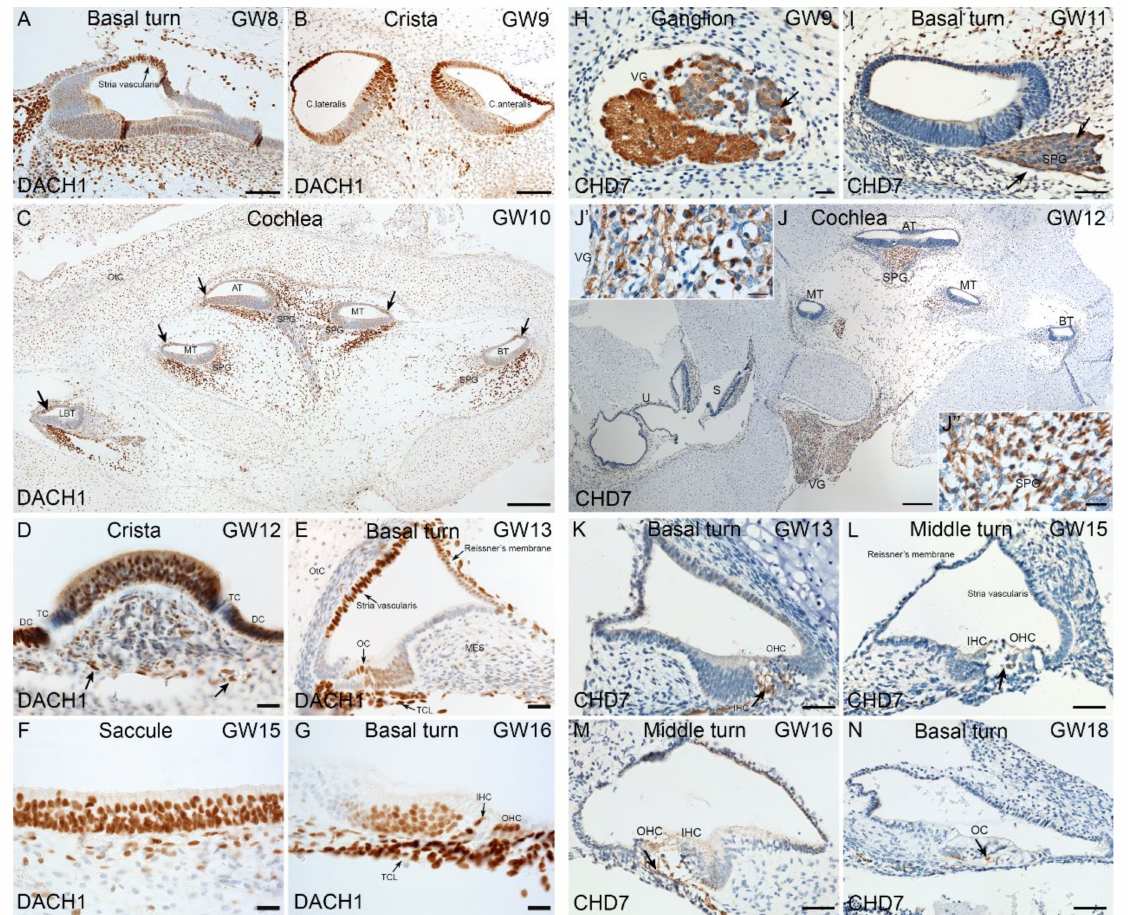
Figure 9. Immunostaining for DACH1 and CHD7 in human inner ear fetal tissue. ( A ) Basal turn of cochlea at GW8. Nuclei of future marginal cells (arrow) in stria vascularis are immuno+ for DACH1. Additionally, mesenchyme cells show strong nuclear staining. ( B ) Cristae ampullaris at GW9. The HCs of lateral and antral crista exhibit strong immunoreactivity in sensory epithelium. Single layered cuboidal epithelial cells of membranous labyrinth are immuno+. Few immuno+ cells observed in the mesenchyme as well. ( C ) Mid-modiolar plane of cochlea at GW10. Strong immunostaining present in mesenchyme underlying sensory epithelium. Few cells of spiral ganglion exhibit immunoreactivity for DACH1. Future stria vascularis (arrows) is immuno+ for this marker. ( D ) Crista ampullaris at GW12. Immunoreaction is present in vestibular HCs and supporting cells. Non-myelinating Schwann cells (arrow) underlying sensory epithelium appear immuno+. Transitional cells (TC) are devoid of immunoreactivity. The dark cells (DC) appear immuno+. ( E ) Cochlear basal turn at GW13. Stria vascularis and Reissner’s membrane immuno+. In organ of Corti (OC), HCs and supporting cells are immuno+. Cells beneath the basilar membrane forming the future tympanic cover layer (TCL) cells are immuno+. ( F ) Sensory epithelia of saccule at GW15. The HCs and supporting cells show a strong immunoreactivity for DACH1. ( G ) Cochlea basal turn at GW16. Outer (OHC), inner hair cells (IHC) and supporting cells are immuno+ for DACH1. Tympanic cover layer (TCL) cells exhibit strong immunoreactivity. ( H ) CHD7 staining in the vestibular ganglion (VG) gestational week (GW) 09. Strong staining in the nerve fibers (arrow). Cytoplasm of the vestibular ganglion cells are also immuno+. Satellite glial cells surrounding the vestibular ganglions are devoid of immunoreactivity. ( I ) Basal turn of cochlea at GW11. Immunoreactivity is present in the nerve fibers (arrows) of the spiral ganglion (SPG) at this stage. ( J ) Overview of the temporal bone at GW12. High immunoreaction observed in the nerve fibers and spiral ganglion at the apical turn (AT) and middle turn (MT). Lowered signal in the basal turn (BT). In the vestibular ganglion, a strong immunostaining is evident at this stage. In the saccule (S) and utricle (U), immunoreactivity is absent. ( J’ ) Insert with higher magnification from the vestibular ganglion where the staining of the nerve fibers is evident. ( J” ) Insert with higher magnification from the spiral ganglion (SPG).